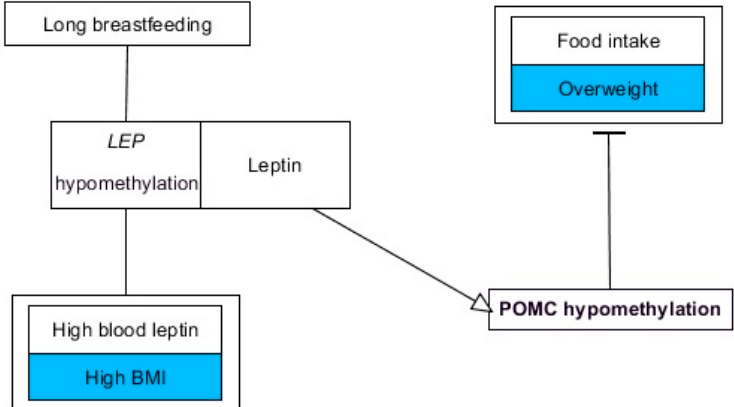
Figure 3. Proposed model of leptin’s participation in perinatal programming. Negative outcomes are highlighted in blue. Associations based on leptin administration are indicated by arrows (stimulation) and T-bars (inhibition). Actions related to boxes refer to all items inside the box. Straight lines indicate correlations. The figure was made using the PathVisio 3.3.0 free open-source software [53].